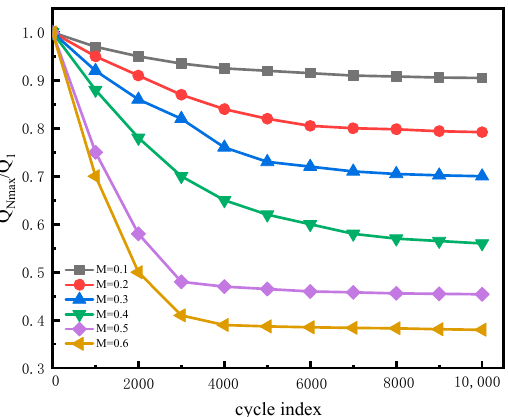
Figure 10. The variation curve of the pile side friction resistance with the cycle times.